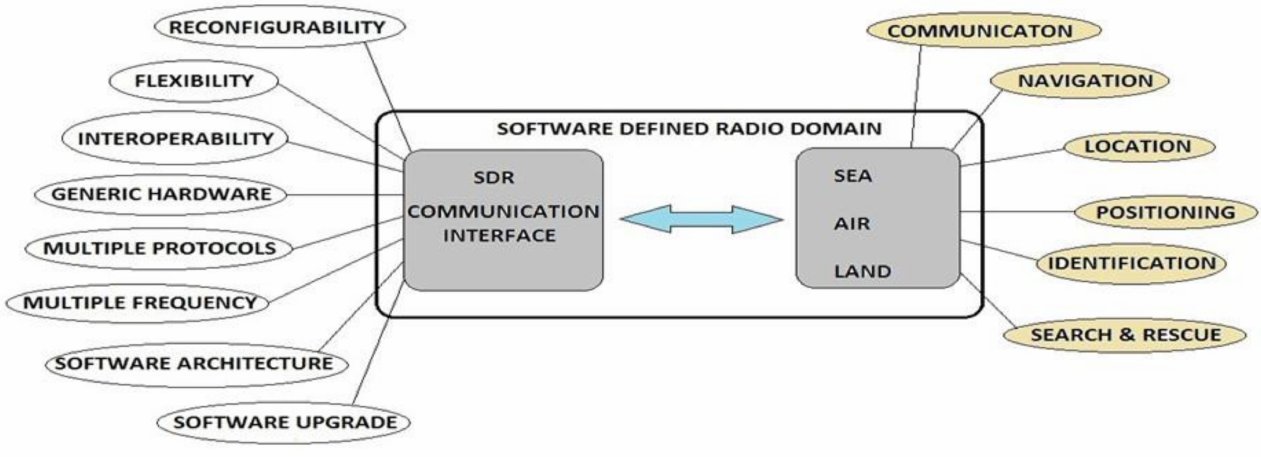
Figure 3. Goals of the SDR system implementation.